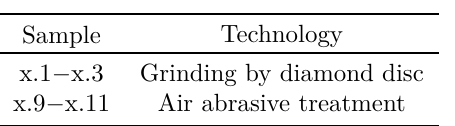
Table 2. Machining technologies of individual series of